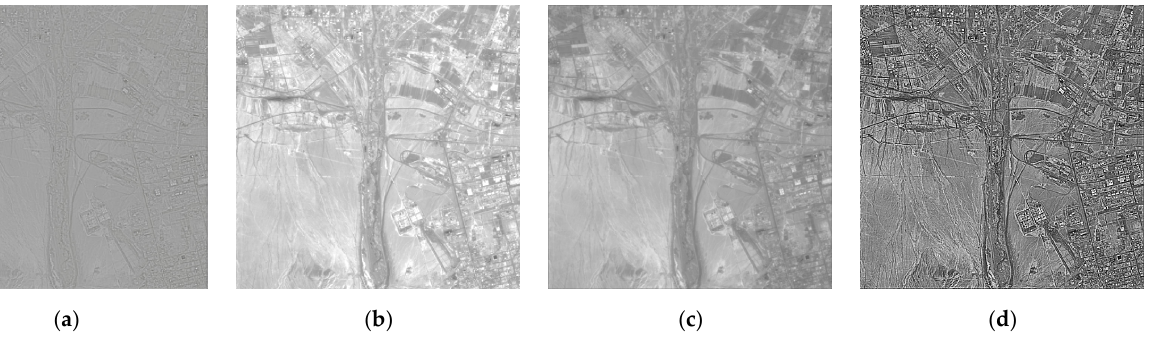
Figure 12. Enhanced image of data 2 by using: ( a ) Retinex-Net; ( b ) LIME; ( c ) ACSEA; ( d ) Proposed IDCP_BFD. Table 7. The quantitative results of the four image enhancement methods.